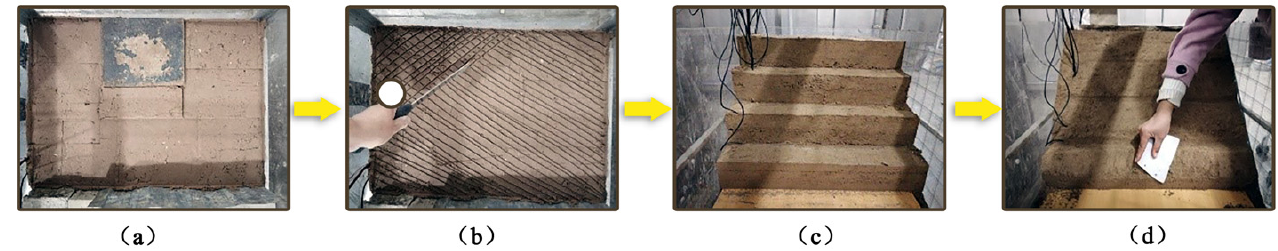
Figure 1. Grain-size distribution curves and compaction test for the soil. ( a ) Ratio and classification of different soil parti- cles; ( b ) compaction curves of the soil. Table 1. Physical properties of the selected expansive soil.